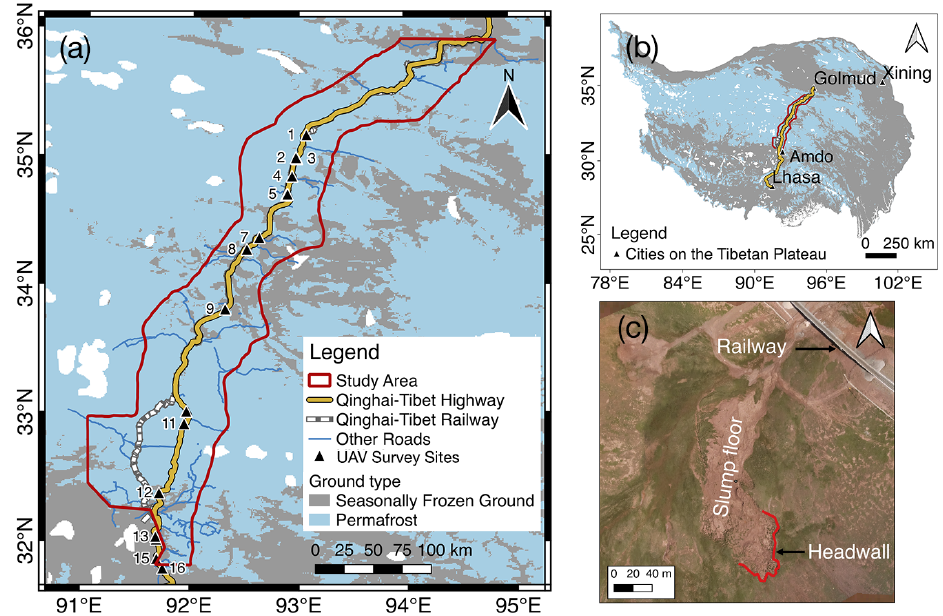
Figure 1. (a) Coverage of the study area and the permafrost distribution. The red boundary is the extent of the study area. The yellow line is the Qinghai–Tibet highway, and the diced line is the Qinghai–Tibet railway, most of which runs close to the highway. Blue lines represent other national roads. The background is the permafrost distribution map produced by Zou et al. (2017), with white patches representing lakes or glaciers. The black triangles label the sites where we conducted UAV investigations. (b) The location of the study area on the Qinghai–Tibet Plateau. (c) A UAV photo of an RTS near the Qinghai–Tibet railway (centre location: 92.883 ◦ E, 34.709 ◦ N).